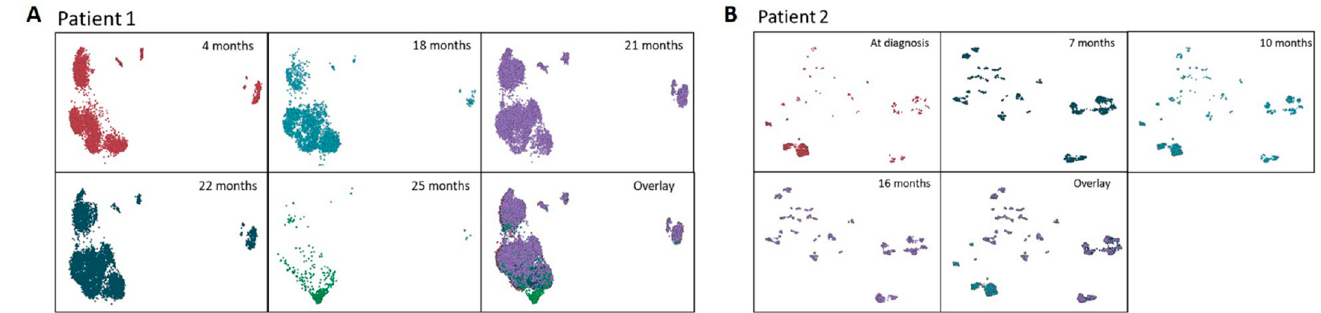
Figure 1. Clonal heterogeneity during treatment by density-based spatial clustering of cells with noise (DBSCAN) based on the allelic burden of SNV and INDELs allele burden in 2 patients with MDS. ( A ): Patient 1 at 4 months (after 4 cycles of AZA), at 18 months (at progression to secondary AML after 18 cycles of AZA), at 21 months (at relapse after the first cycle of midostaurin and high- dose cytarabine consolidation), at 22 months (non-remission to one cycle of venetoclax-DEC) and at 25 months (non-remission after 3 months of Gilteritinib); ( B ): Patient 2 at diagnosis, at 7 months (before the first cycle of AZA), at 10 months (after 3 cycles of AZA), and at 16 months (at progression to secondary AML after 9 cycles of